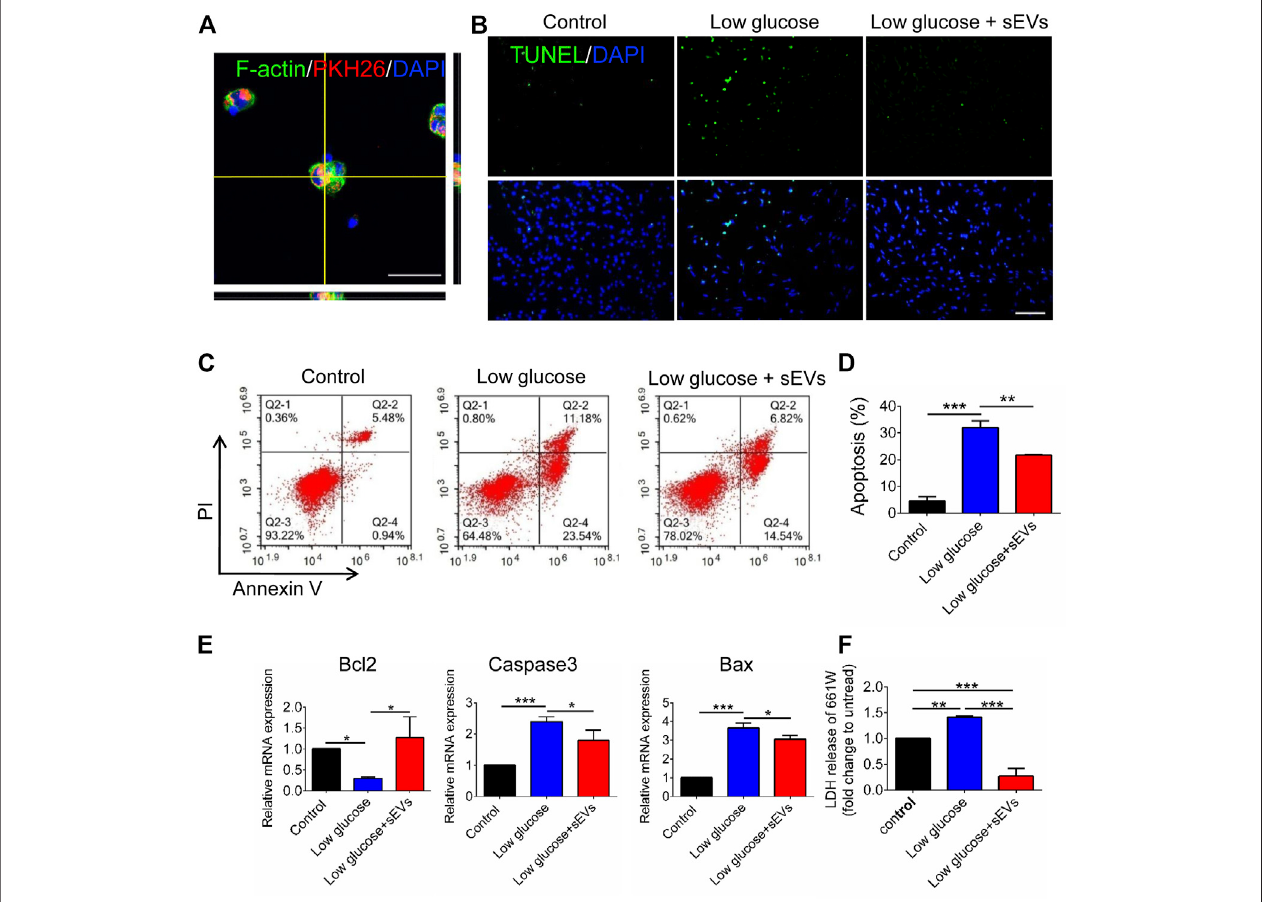
FIGURE 3 | hRPC-sEVs protect 661W cells from apoptosis in low-glucose preconditioned culture. (A) Representative confocal images showing the hRPC-sEVs (PKH26-labeled, red) are localized with Factin-labeled mouse 661W cells (green). (B) Confocal images of TUNEL (green, top panel ) and DAPI (blue, bottom panel ) staininginlow-glucosecultured661Wcells.hRPC-sEV – treatedgroupsshowlowTUNEL-positive labelingcomparedwiththePBSgroups(n (cid:2) 3). Scalebar,50 μ m. (C) FlowcytometryrepresentativeimagesshowingAnnexin V/PIstainingincontrol(normalglucose),lowglucose withouttreatment, andlowglucosewithtreatment of hRPC-sEVs(n (cid:2) 3pergroup).Thedouble-positivecellsareend-stagenecroticcells.AlowerpercentageofQ2-2cells(6.82%)inhRPC-sEV – treatedgroupcomparedto non-treated group (11.18%), suggesting that hRPC-sEVs are protecting 661W cells from death. (D) Statistical analysis of the apoptosis assays from fl ow cytometry testing(n (cid:2) 3). (E) Real-timeqPCRanalysisshowingrelativemRNAexpressionofapoptoticfactorsBax,Caspase3,andBcl2inthe661Wcells.hRPC-sEV – treated661W cells signi fi cantly reverse the high levels of Bax and caspase3 and the low level of Bcl2 (n (cid:2) 3). (F) LDH release of 661W cells (n (cid:2) 3). hRPC-sEV treatment dramatically reduces the LDH release in 661W cells compared to the untreated group (n (cid:2) 3 per group). Data are shown as means ± SD. * p < 0.05, ** p < 0.01, and *** p < 0.001.